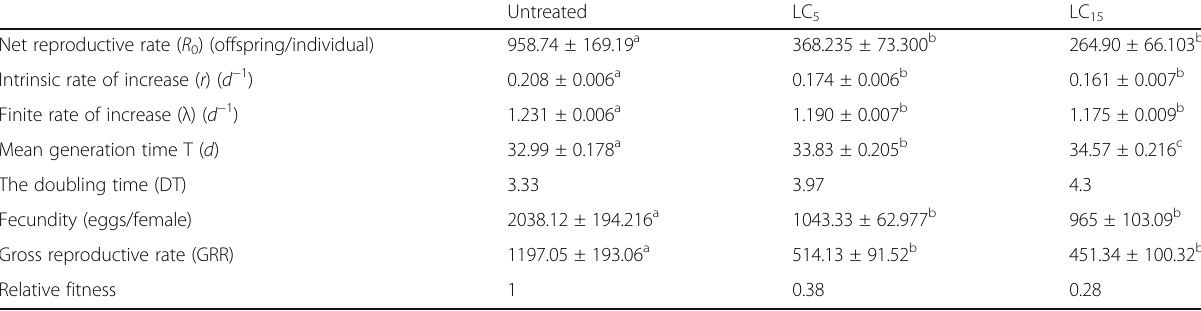
Table 3 The sublethal effects of emamectin benzoate on S. littoralis population parameters